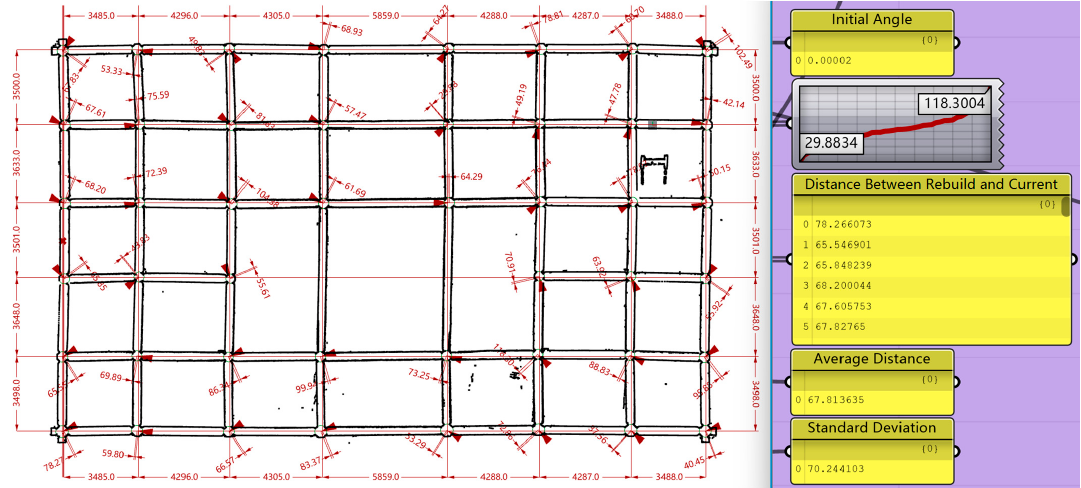
Figure 9. The result of the solution process and numerical analysis of this moment. As is shown in Figure 9, displacements of column heads including vectors (arrows) and lengths (numbers) are calculated, while all of the axes are generated. The solution process takes 3 h 16 min and stops automatically after reaching the minimum value .